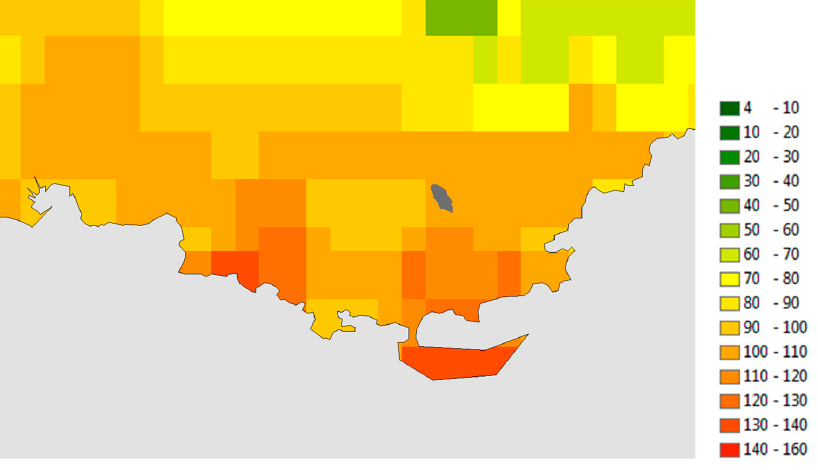
Figure 8. Fire spreading overlaid by extreme 95% value of FWI under RCP85 period: 2036–2045. The FireTactic output then fed the Fire Emission Production Simulator (FEPS), a USDA Forest Service Pacific Wildland Fire Sciences Lab product [46], designed to manage data concerning consumption, emissions and heat release characteristics of prescribed burns and wildland fires. This produced hourly estimates of PM2.5 including burned areas, plume rise from the resulting fire radiative power. The hourly emissions were fed into the Hybrid Single Particle Lagrangian Integrated Trajectory Model (HYSPLIT) computer model [47,48] that is used to derive the concentration of smoke for the area of interest for a period of 12 hours from the fire-starting time. Figure 9 displays a snapshot of the produced smoke concentration (in µ gr/m 3 ), which was used to drive the impact models.